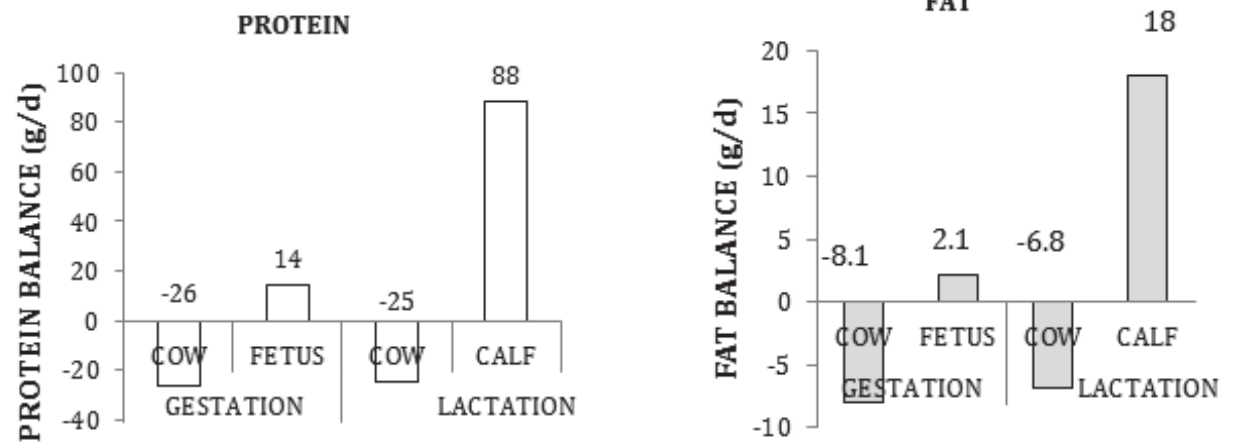
Fig. 3. Balance of protein (a) and fat (b) in caribou at term gestation and at three week lactation in relation to protein and fat deposition of the fetus and calf in caribou given diets of known composition. Calculations are based on data of Barboza & Parker (2008). Stable isotope analysis was used by Barboza and Parker to deduce the maternal versus dietary sources of protein and fat deposited in the